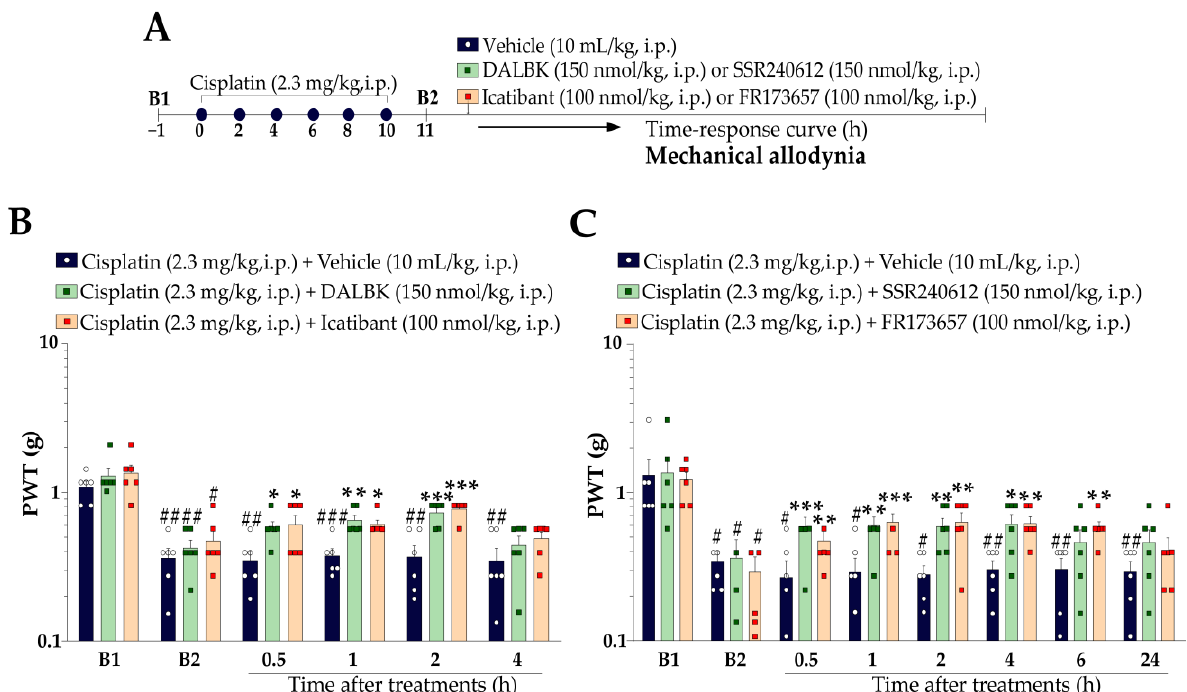
Figure 3. Therapeutic effect of kinin B 1 and B 2 receptor antagonists on cisplatin-induced mechanical allodynia. ( A ) Therapeutic protocol : Male Swiss mice were treated intraperitoneally (i.p.) with cispla- tin (2.3 mg/kg) every 48 h for 10 days. On the 11 th day after the first cisplatin dose, the animals received a single administration of DALBK or SSR240612 (150 nmol/kg, i.p., peptide and non-peptide kinin B 1 receptor antagonist, respectively), Icatibant or FR173657 (100 nmol/kg, i.p., peptide and non-peptide kinin B 2 receptor antagonist, respectively), or vehicle (10 mL/kg, i.p.). Time – response curve for mechanical allodynia after treatment with DALBK or Icatibant ( B ) and SSR240612 or FR173657 ( C ). Baseline 1 (B1) values were measured before the first cisplatin dose. Baseline 2 (B2) values were measured on the 11 th day after the first cisplatin dose and before the treatments. The symbols on the bars indicate individual values for each animal. # p < 0.05, ## p < 0.01 and ### p < 0.001 vs. B1 values. * p < 0.05, ** p < 0.01, and *** p < 0.001 vs. cisplatin plus vehicle group. Data are ex- pressed as the mean + SEM (n = 6/group) and were analysed by two-way ANOVA followed by the Bonferroni post hoc test. PWT: paw withdrawal threshold.